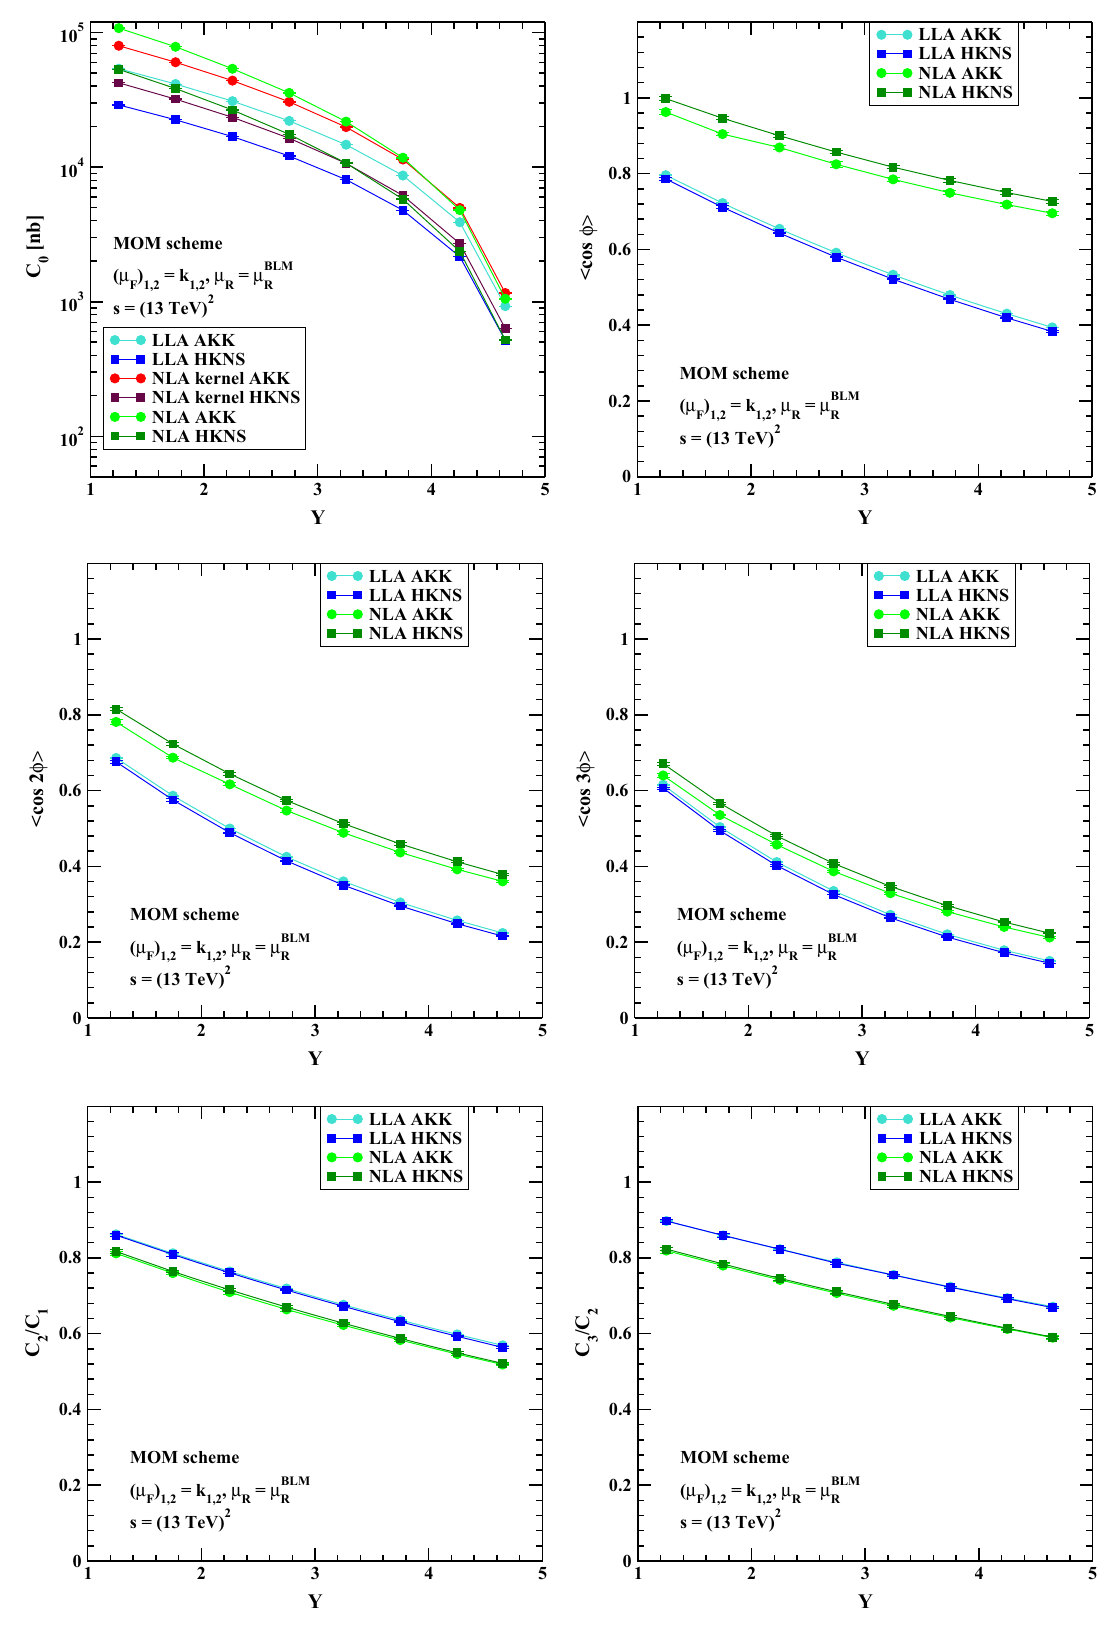
Fig. 6 Y -dependence of C 0 and of several ratios C m / C n for (μ F ) 1 , 2 = |(cid:6) k 1 , 2 | ,